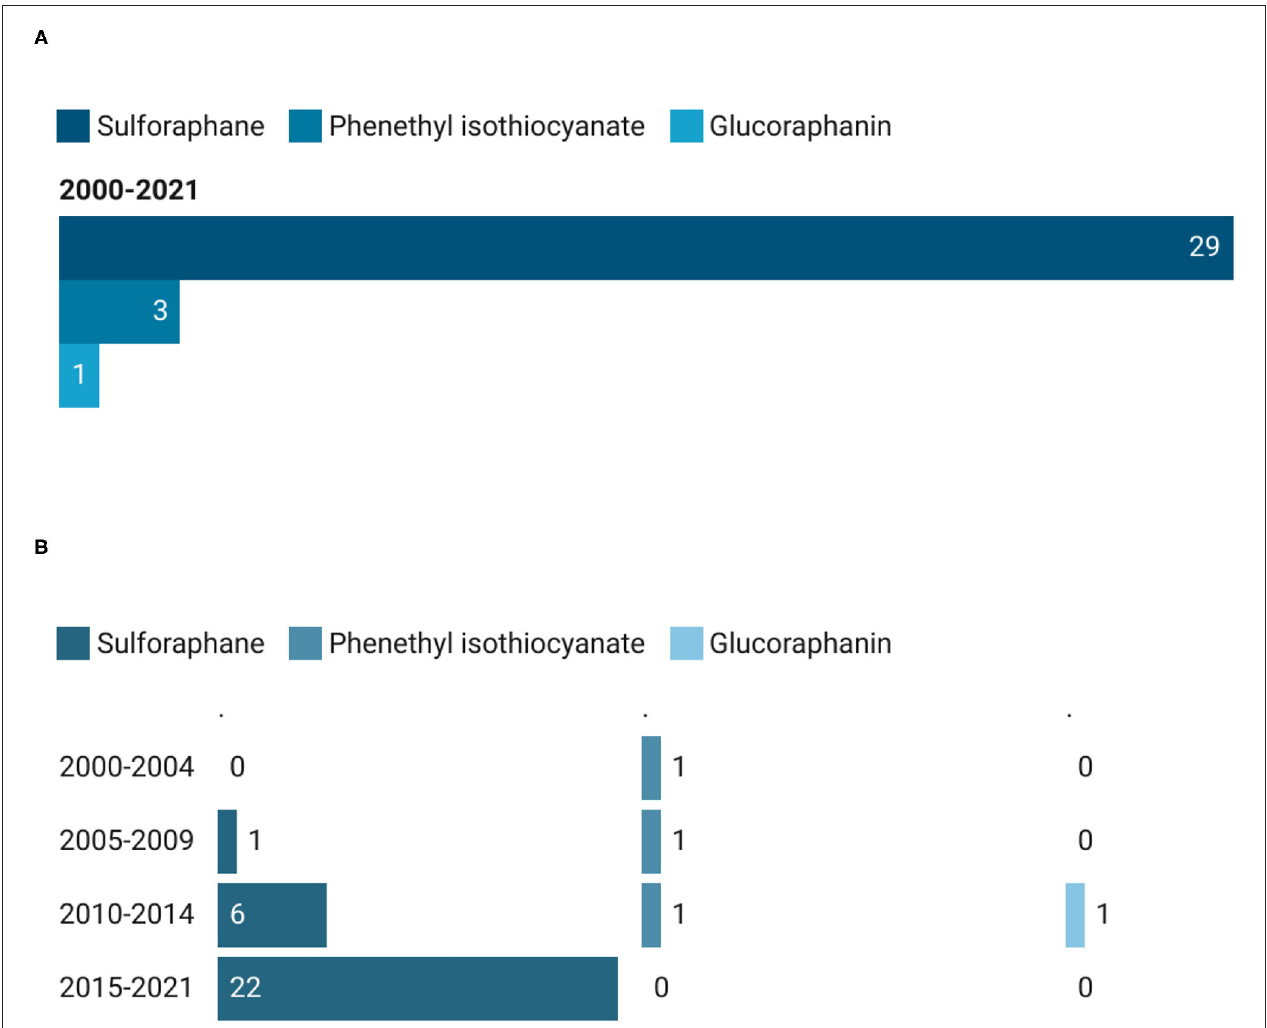
FIGURE 5 | Main pure GSLs used in clinical trials (A) and their trend (B) . The total count of pure GSLs is higher than the total count of the corresponding studies since in some studies more than one GSL has been provided to the